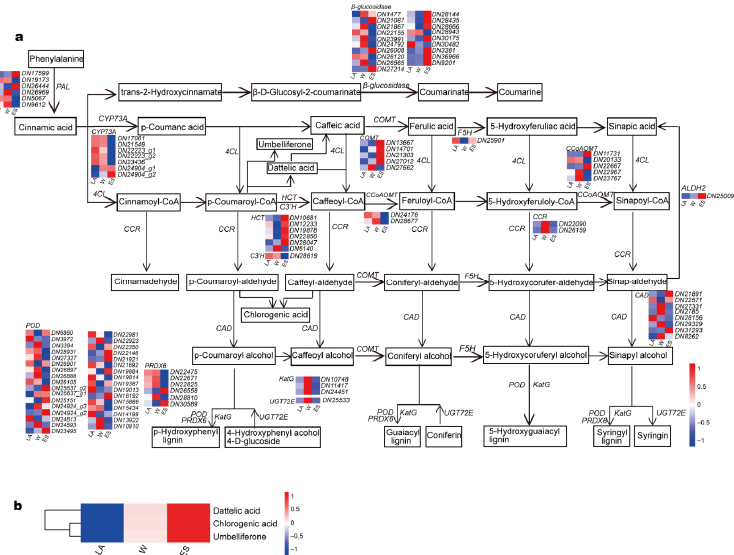
Figure 5. Metabolites and unigenes associated with phenylpropanoids that were differentially expressed in overwintering C. fortunei . ( a ) Unigenes involved in phenylpropanoid biosynthesis pathway. Boxed text indicates the metabolites in the metabolic pathway. Heatmap represents unigene expression levels after normalizing the row data, and red and blue represent high and low expression, respectively. Each column and each row represent a sample and a unigene, respectively. The content in italics indicates genes, and the gene abbreviations are as follows: 4CL , 4-coumarate-CoA ligase ; ALDH2 , coniferyl-aldehyde dehydrogenase ; C3’H , 5-O-(4-coumaroyl)-D-quinate